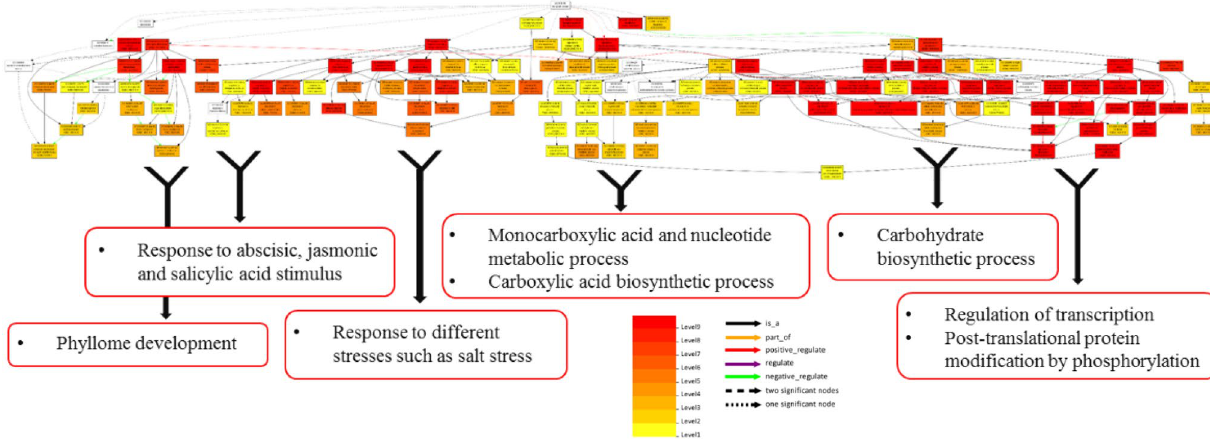
Figure 7. Biological process graphical results of 525 salt responsive coding target genes of five selected miRNAs. Graphical results were prepared through the AgriGO v2.0 web-based tool (http:// syste msbio logy. cau. edu. cn/ agriG Ov2/).